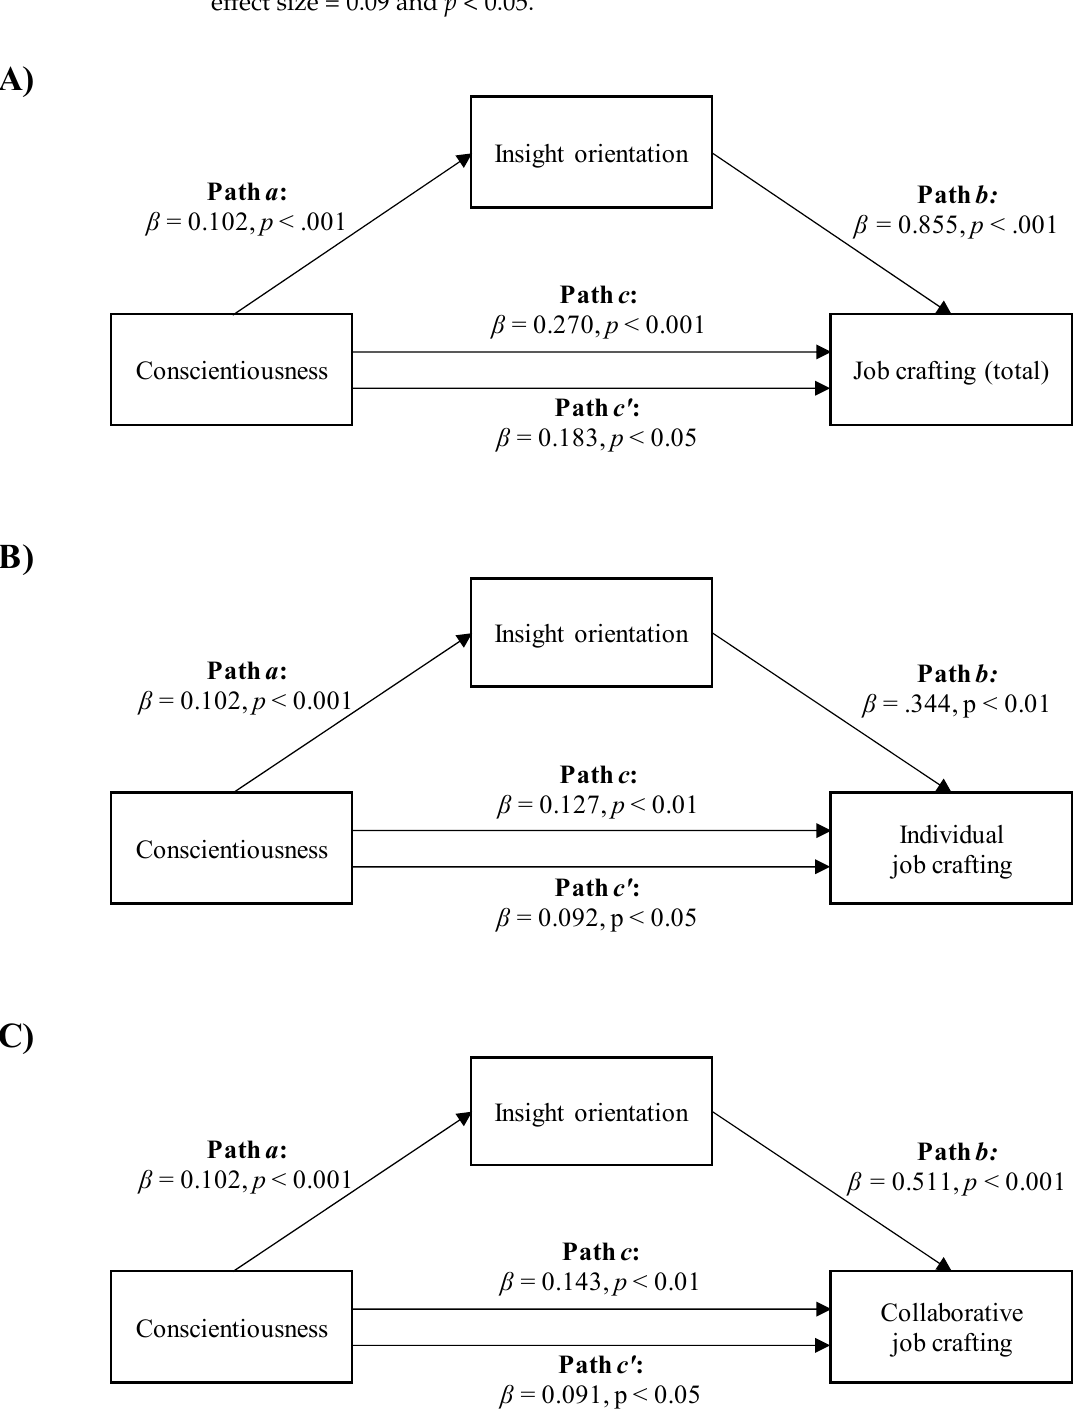
Figure 3. The mediation of insight orientation in the relationships between conscientiousness and total job crafting score. ( A ) R 2 mediator effect size = 0.09, ( p < 0.05), individual job crafting ( B ) R 2 mediator effect size = 0.07, ( p < 0.05) or collaborative job crafting; ( C ) R 2 mediator effect size = 0.09, ( p < 0.05).